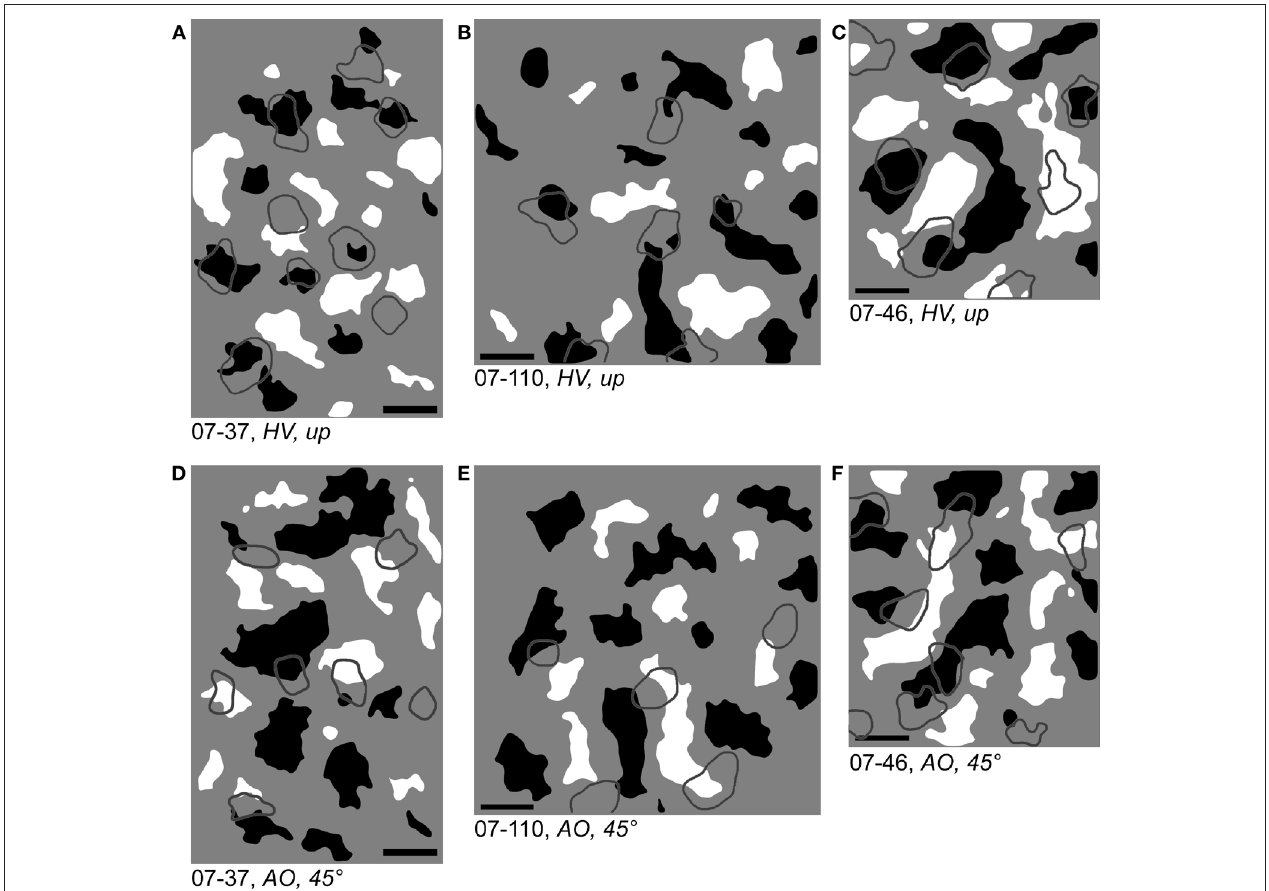
domains (H), top row and acute domains (A), bottom row are indicated in black. Vertical domains (V), top row and oblique domains (O) bottom row are indicated in white. Up domains (top row) and 45 ° domains (bottom row) are indicated with gray lines. Black and white domains (axis-of-motion) domains appear larger and more elongated than direction-of motion domains (circled in gray). Scale bar: 500